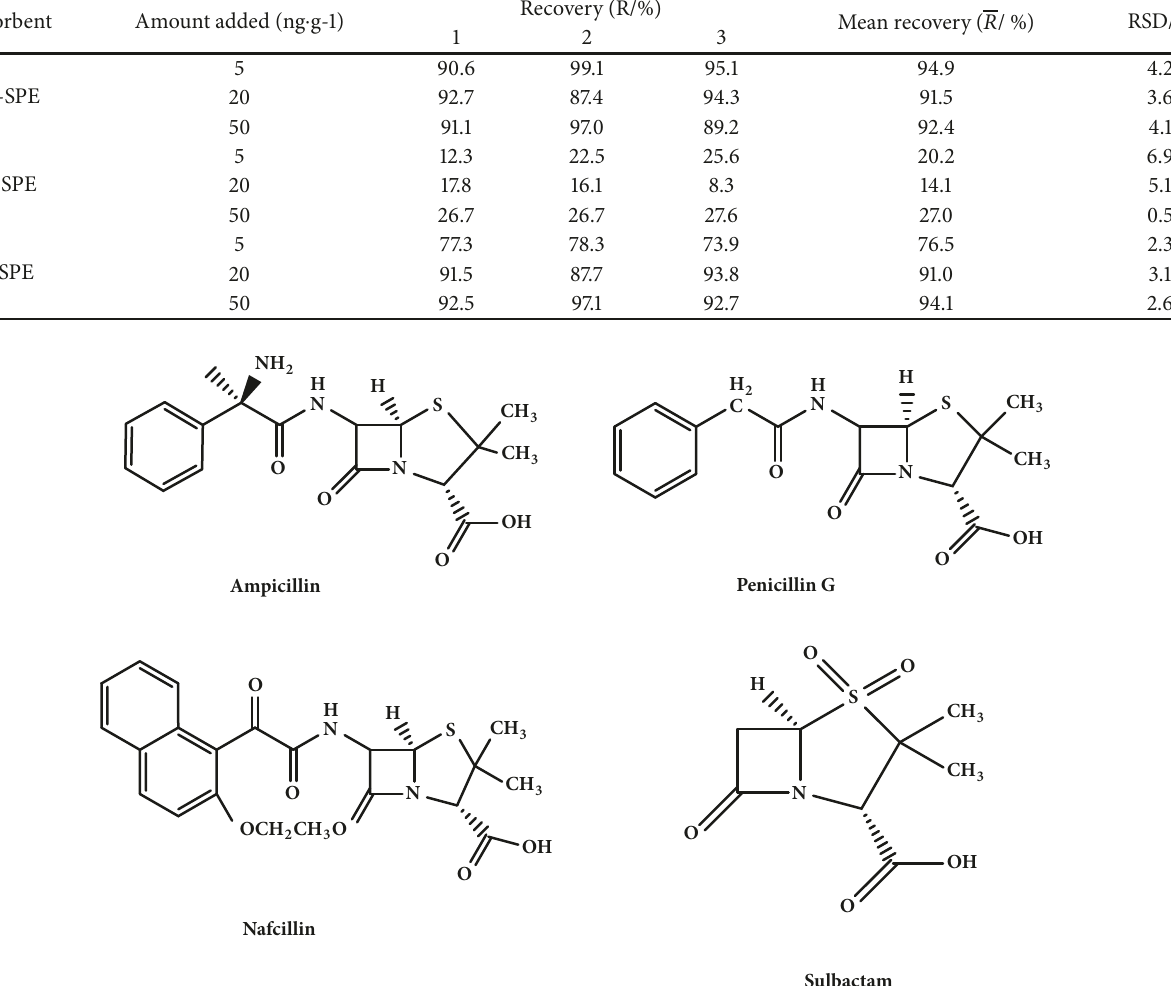
Figure 8: The structures of ampicillin, penicillin G, nafcillin, and sulbactam.